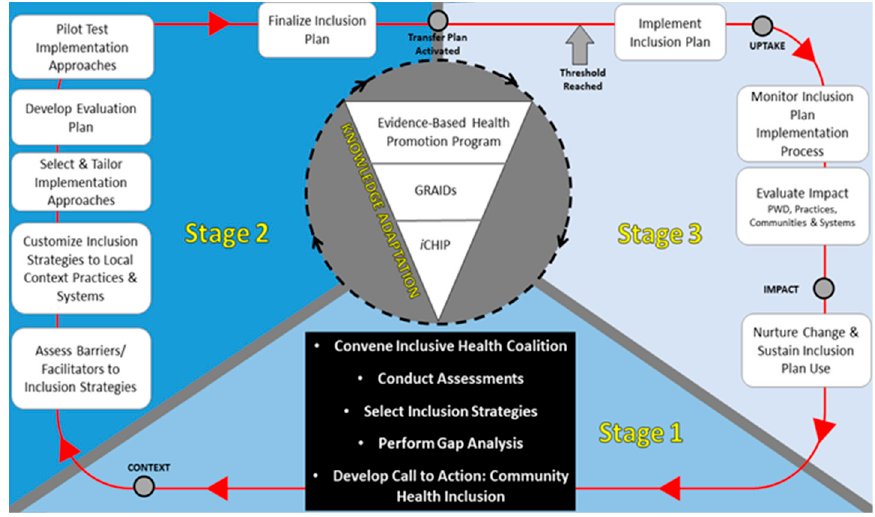
Figure 2. NCHPAD inclusive CAN-IMPLEMENT Process.